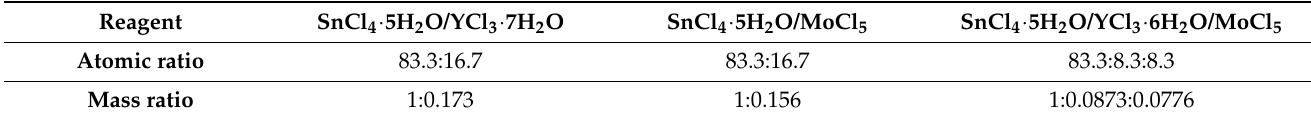
Table 1. Atomic ratio and mass ratio.